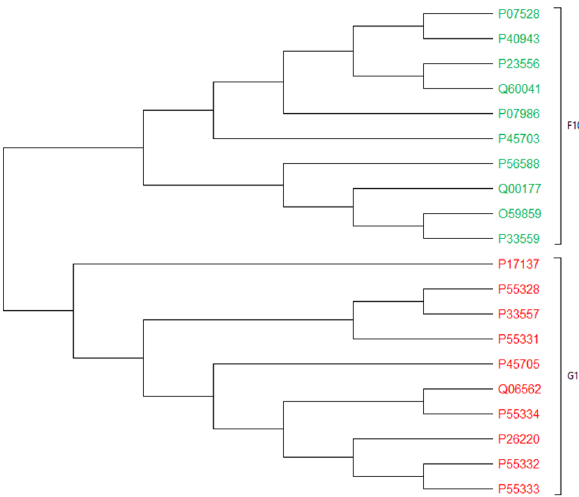
Figure 16. The phylogenetic tree of 20 Xylanase proteins constructed by our method